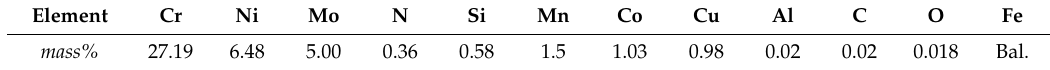
Table 1. Chemical composition of UNS S32707 hyper-duplex stainless steel (HDSS) powder. Element Cr Ni